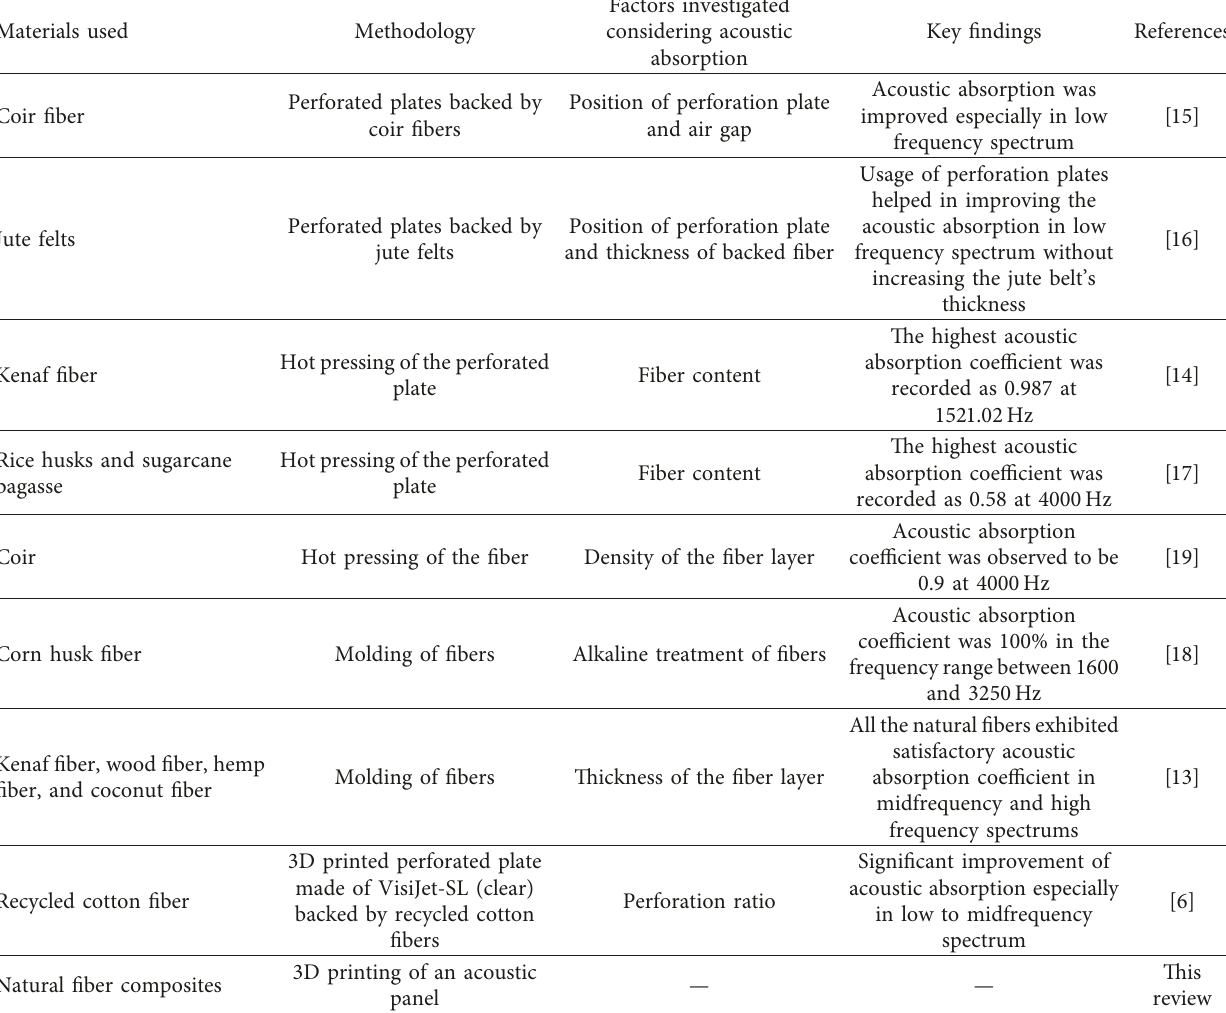
Table 1: Acoustic panels made of natural fibers and their composites along with the methodology and key findings. Materials used